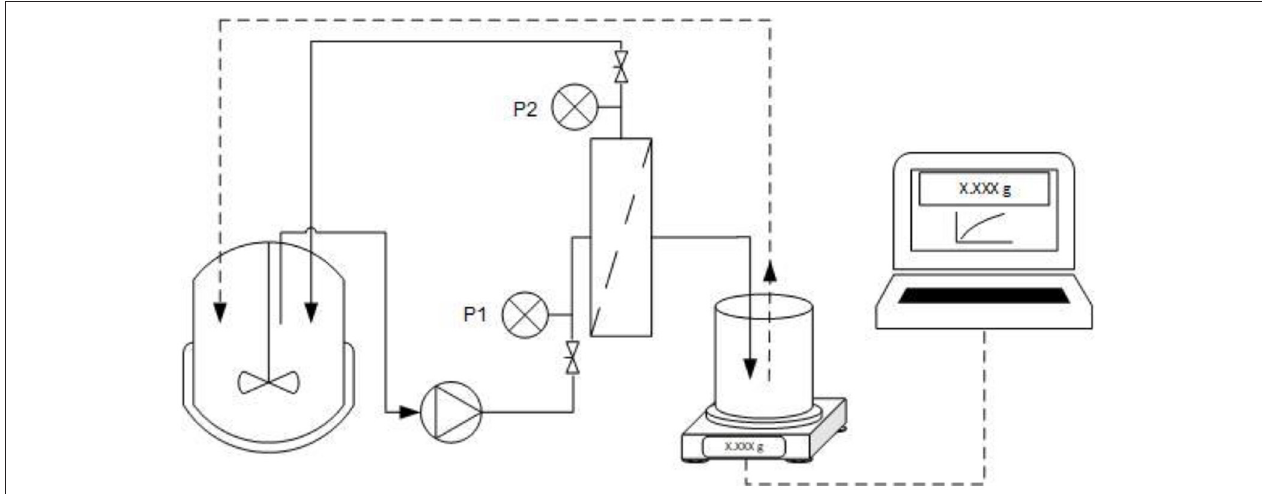
FIGURE 1 | Experimental setup for ultrafiltration. The setup includes pressure indicators (P1 and P2), a balance to determine mass transfer through the membrane, and a computer to record filtrate data. The filtration was operated in total recycling mode with a cross-flow velocity of 0.3 m · s − 1 .